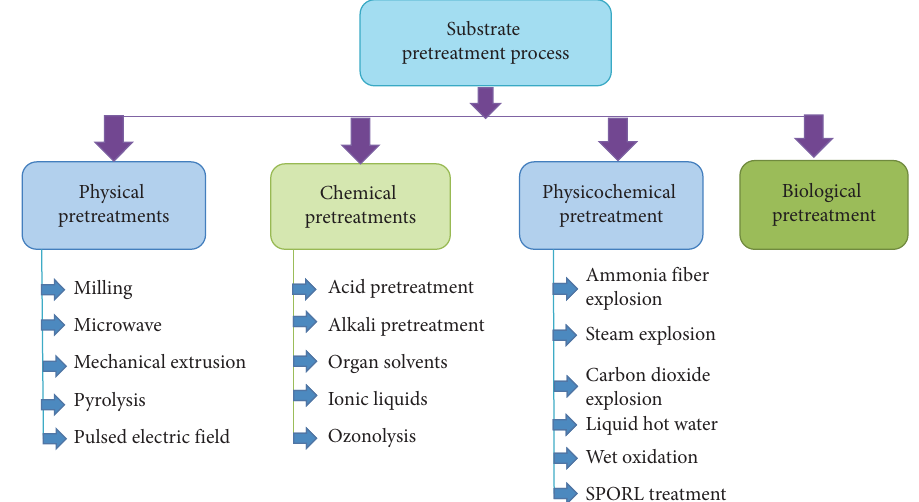
Figure 3: Diferent processes of the substrate pretreatment.